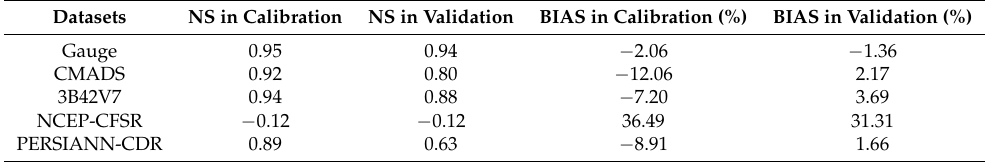
Figure 6. Monthly simulated flow in Xiangtan station with precipitation from gauge ( a ), PERSIANN-CDR ( b ), NCEP-CFSR ( c ), CMADS ( d ), and 3B42V7 ( e ) (In the scatter plot, pearsonr represents Pearson’s correlation coefficient, p represents the significance of paired t-test, and the shade represents the 0.95 confidence interval). Table 4. NS coefficient and BIAS of monthly simulated streamflow (The number outside and inside the parenthesis is for the calibration period and validation period